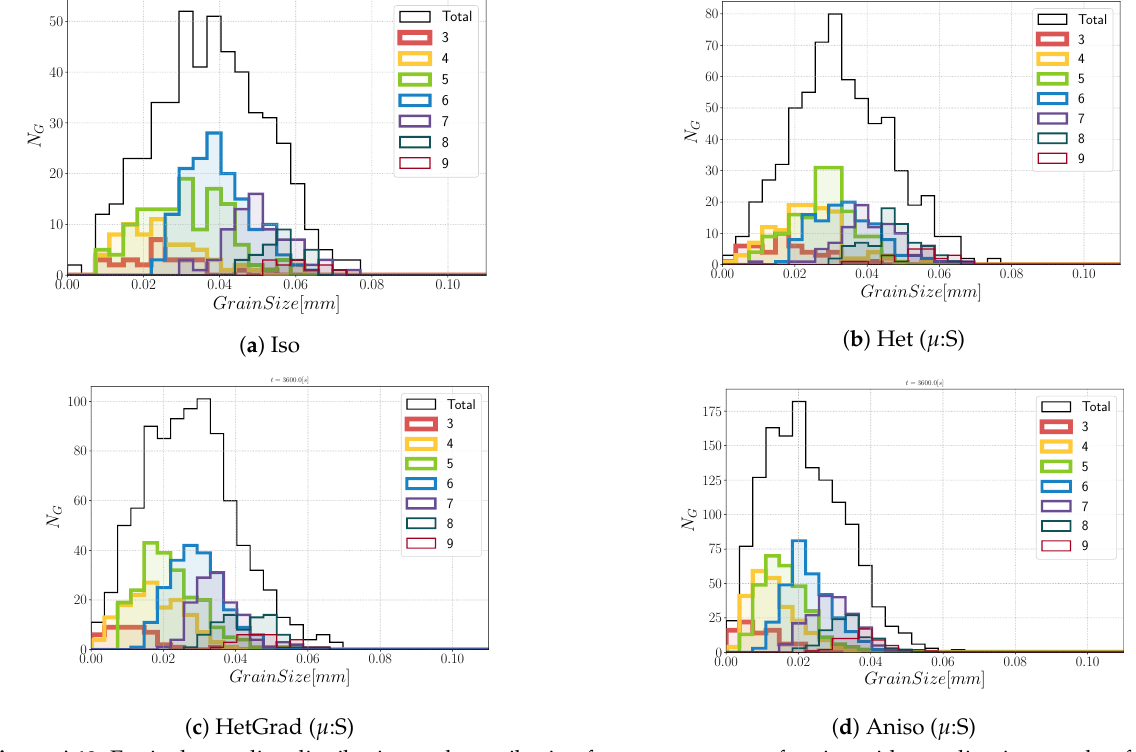
Figure B.9. Disorientation of the boundaries using the four formulations with heterogeneous grain boundary mobility at t = 1 h , boundaries with a disorientation higher than 30 ◦ are colored in red.